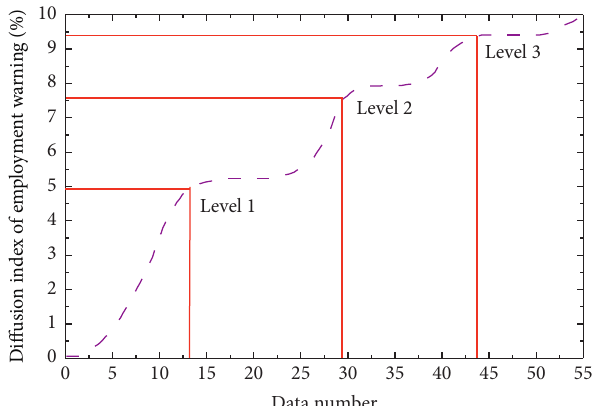
Figure 4: Diffusion index curve of employment warning.